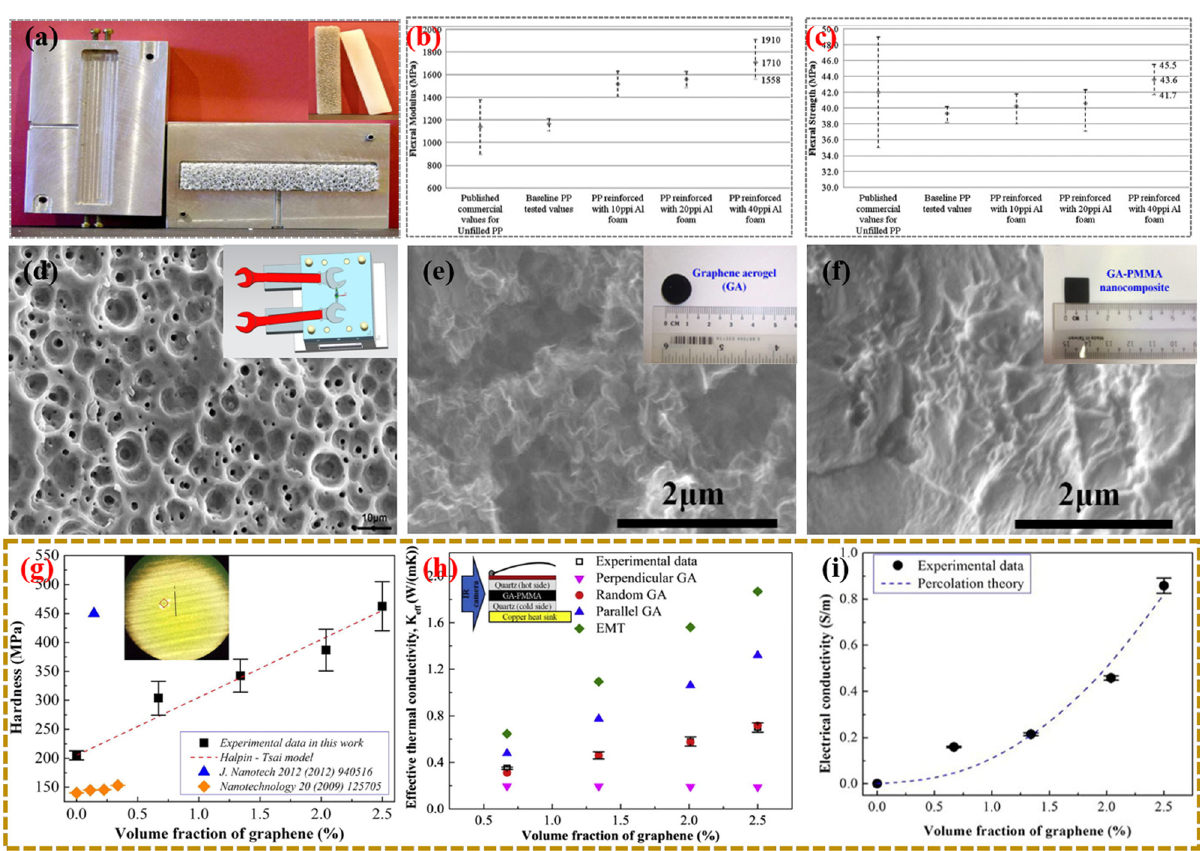
Figure 3: ( a ) Injection mold and AF/PP composite spline; ( b ) fl exural modulus; and ( c ) strength of splines with di ff erent porosity [ 30 ] ( Copyright 2010, Elsevier ) . ( d ) Schematic diagram of matrix and composite with micropore and nanopore structure morphology prepared by NMT technology [ 38 ] ( Copyright 2021, Walter De Gruyter ) . ( e ) GA and ( f ) PMMA - fi lled GA digital photos and their FESEM pictures. The ( g ) hardness, ( h ) thermal conductivity, and ( i ) electrical conductivity of GA/PMMA composites were prepared with the variation in graphene content [ 40 ] ( Copyright 2013, Multidisciplinary Digital Publishing Institute )